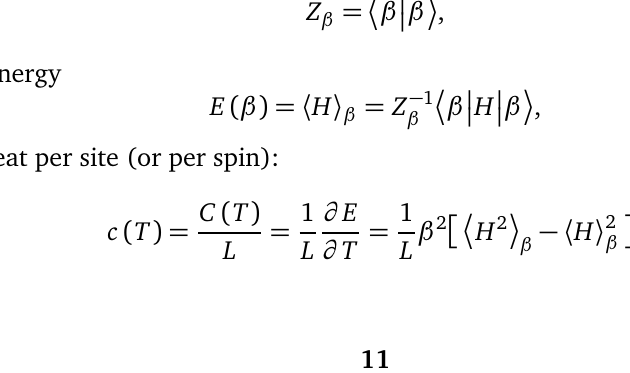
Figure 7: Visualization of the nearest-neighbour spin-spin correlations 〈 S · S the first excited singlet state, S lower part is highlighted with